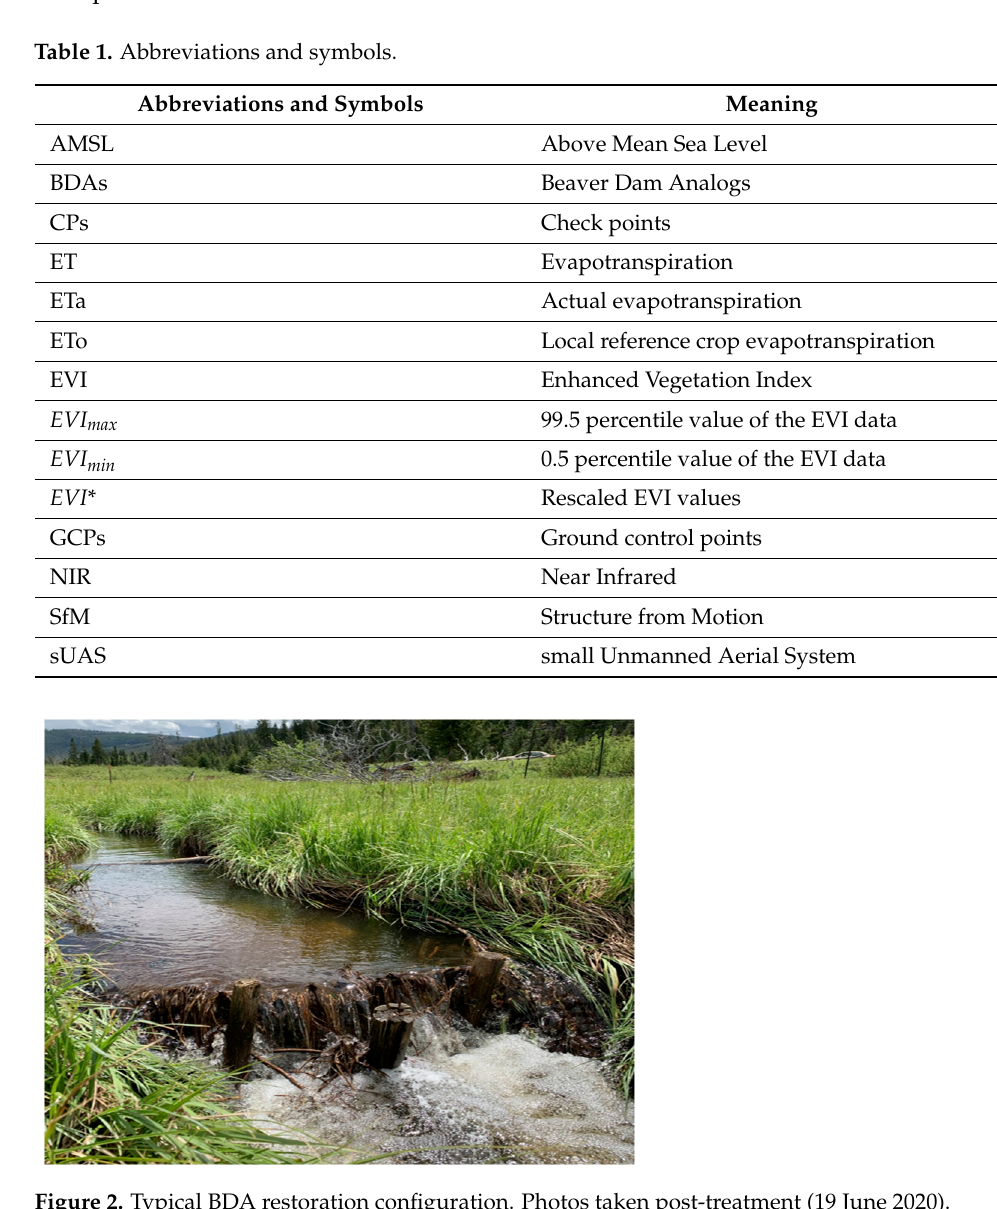
Figure 2. Typical BDA restoration configuration. Photos taken post-treatment (19 June 2020).